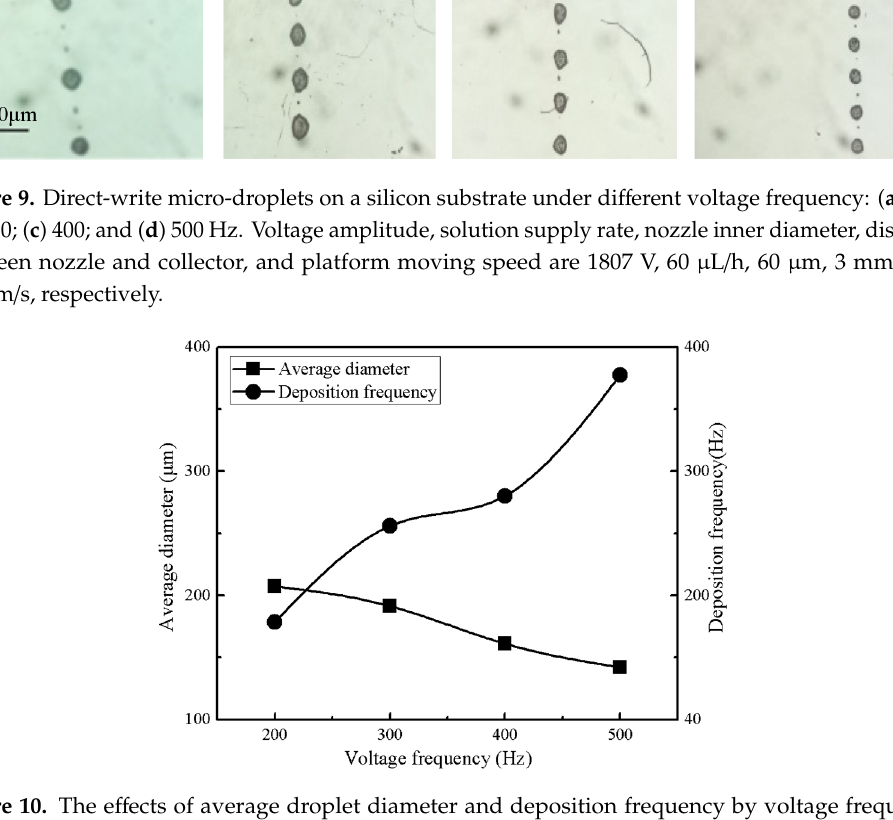
Figure 10. The effects of average droplet diameter and deposition frequency by voltage frequency. Voltage amplitude, solution supply rate, nozzle inner diameter, distance between the nozzle and collector, and platform moving speed are 1807 V, 60 μL/h, 60 μm, 3 mm, and 50 mm/s, respectively.